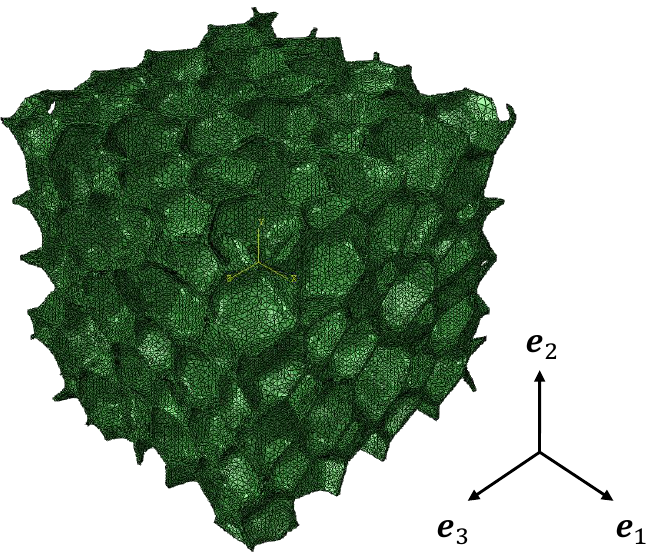
Figure 7. The periodic irregular closed-cell model with 821,087 elements.